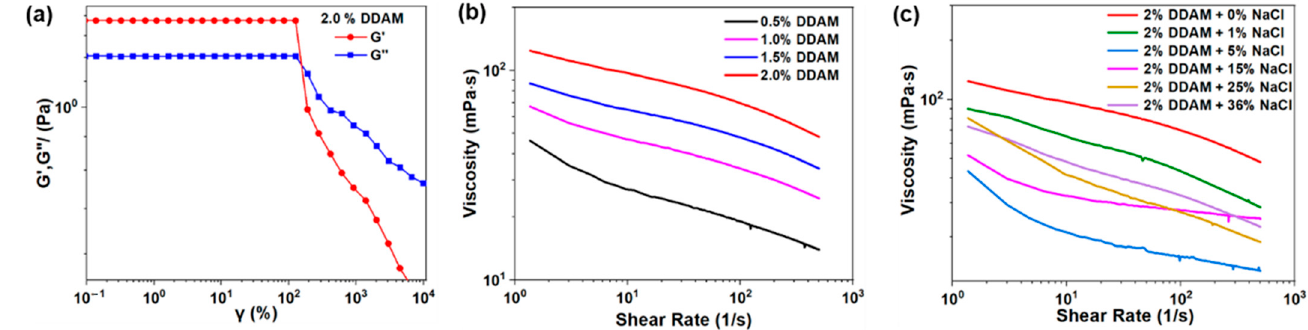
Figure 3. ( a ) Viscoelastic behavior of DDAM solution ( b ) Viscosity curves of DDAM with different concentration ( c ) Viscosity curves of 2 wt% DDAM in different NaCl concentration.